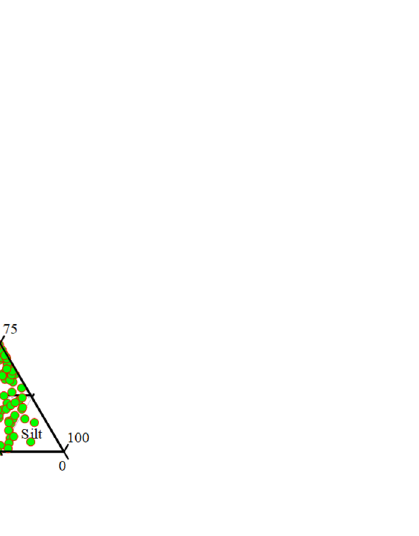
Figure 2. Triangle map of soil texture